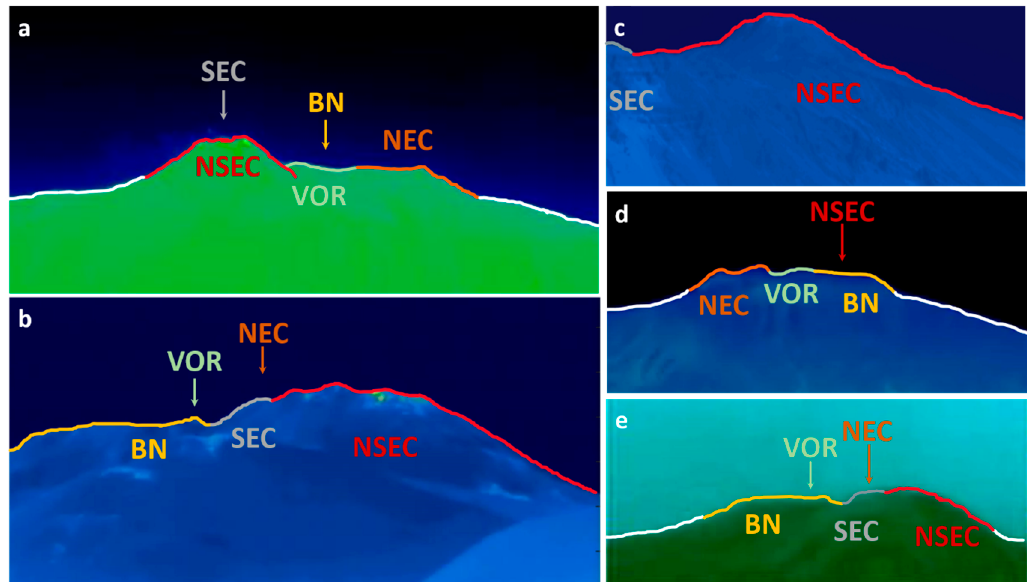
Figure 2. Summit area views from EMCT ( a ), EMOT ( b ), ESR ( c ), EBT ( d ), and ENT cameras. Each color curve is associated with the corresponding summit crater name, while the arrows indicate that the corresponding craters are out of sight. The white curve delimits the outline of the flanks of Etna.